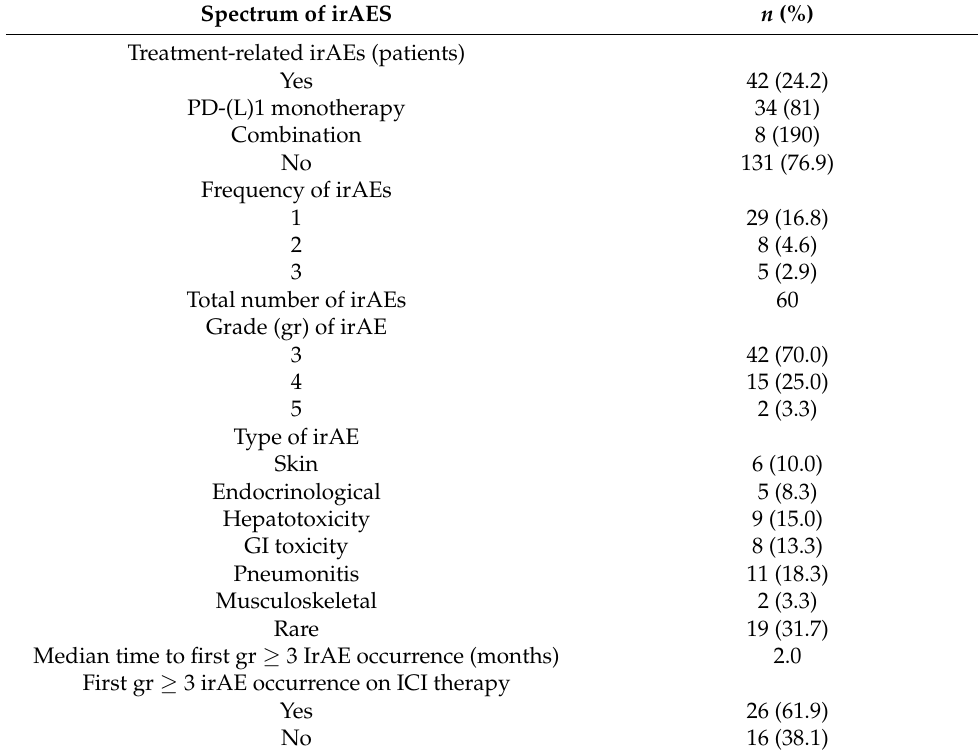
Table 2. Grade 3–5 immune-related (ir) adverse events in the whole cohort.